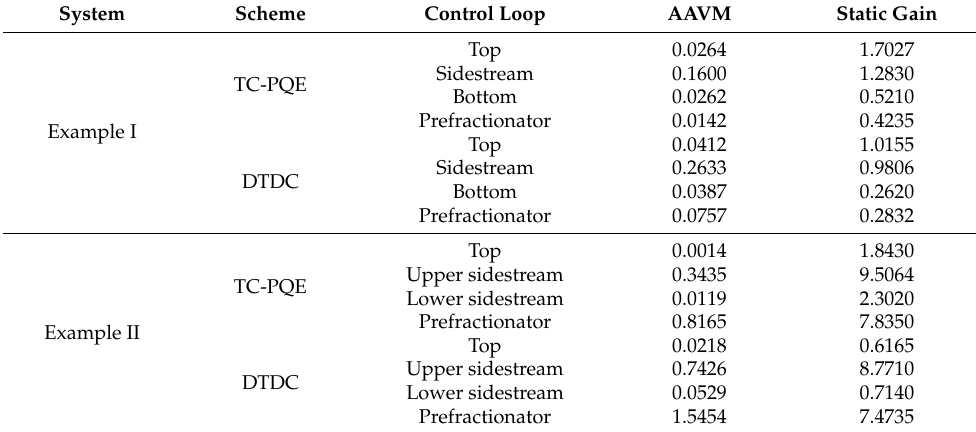
Table 2. AAVM and static gains for the four control loops of the DTDC and TC-PQE schemes (Examples I and II).